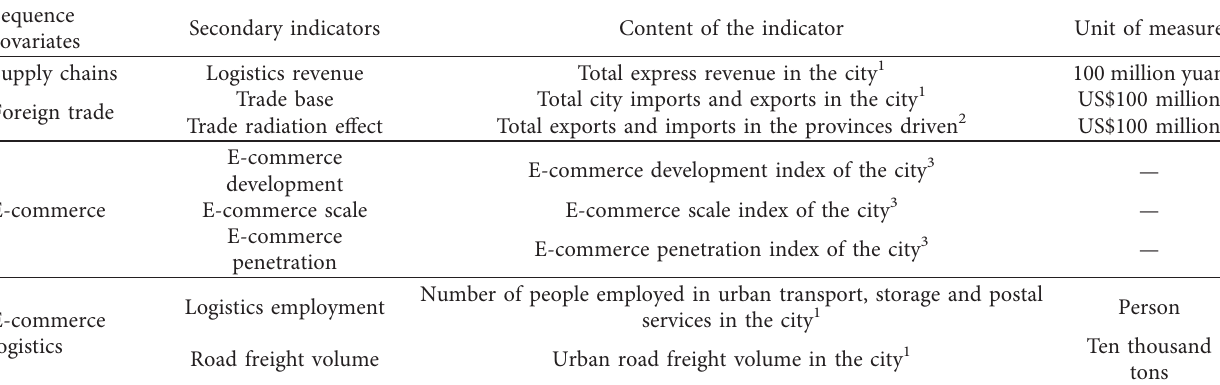
Table 1: Sequential covariate index system of the CBECSC